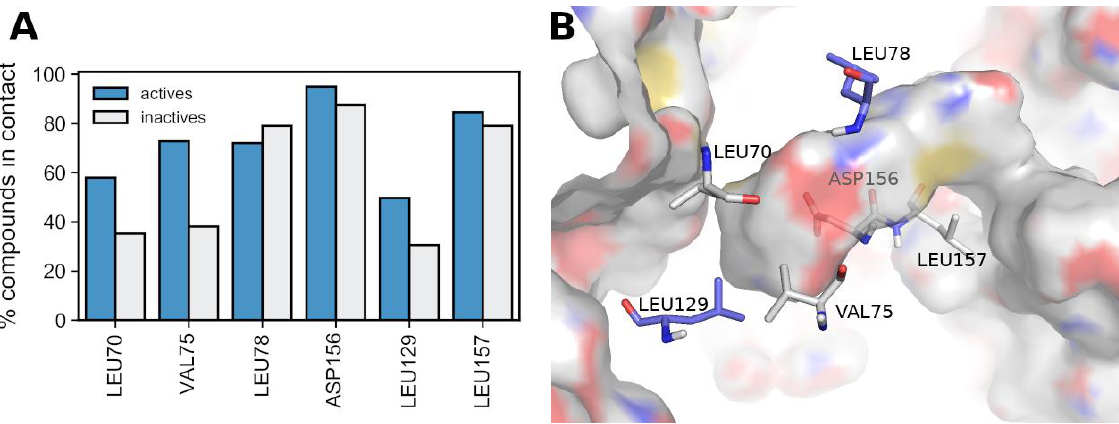
Figure 9. ( A ) Frequency (%) of contacts between the six key residues involved in binding with active versus inactive compounds. ( B ) The six key residue contacts selected from common shared contacts across RIPK1 X-ray structures. The four residues in grey correspond to the signature of simultaneous residues that, as a group, are statistically more prevalent in actives than in inactives across the multiple datasets.